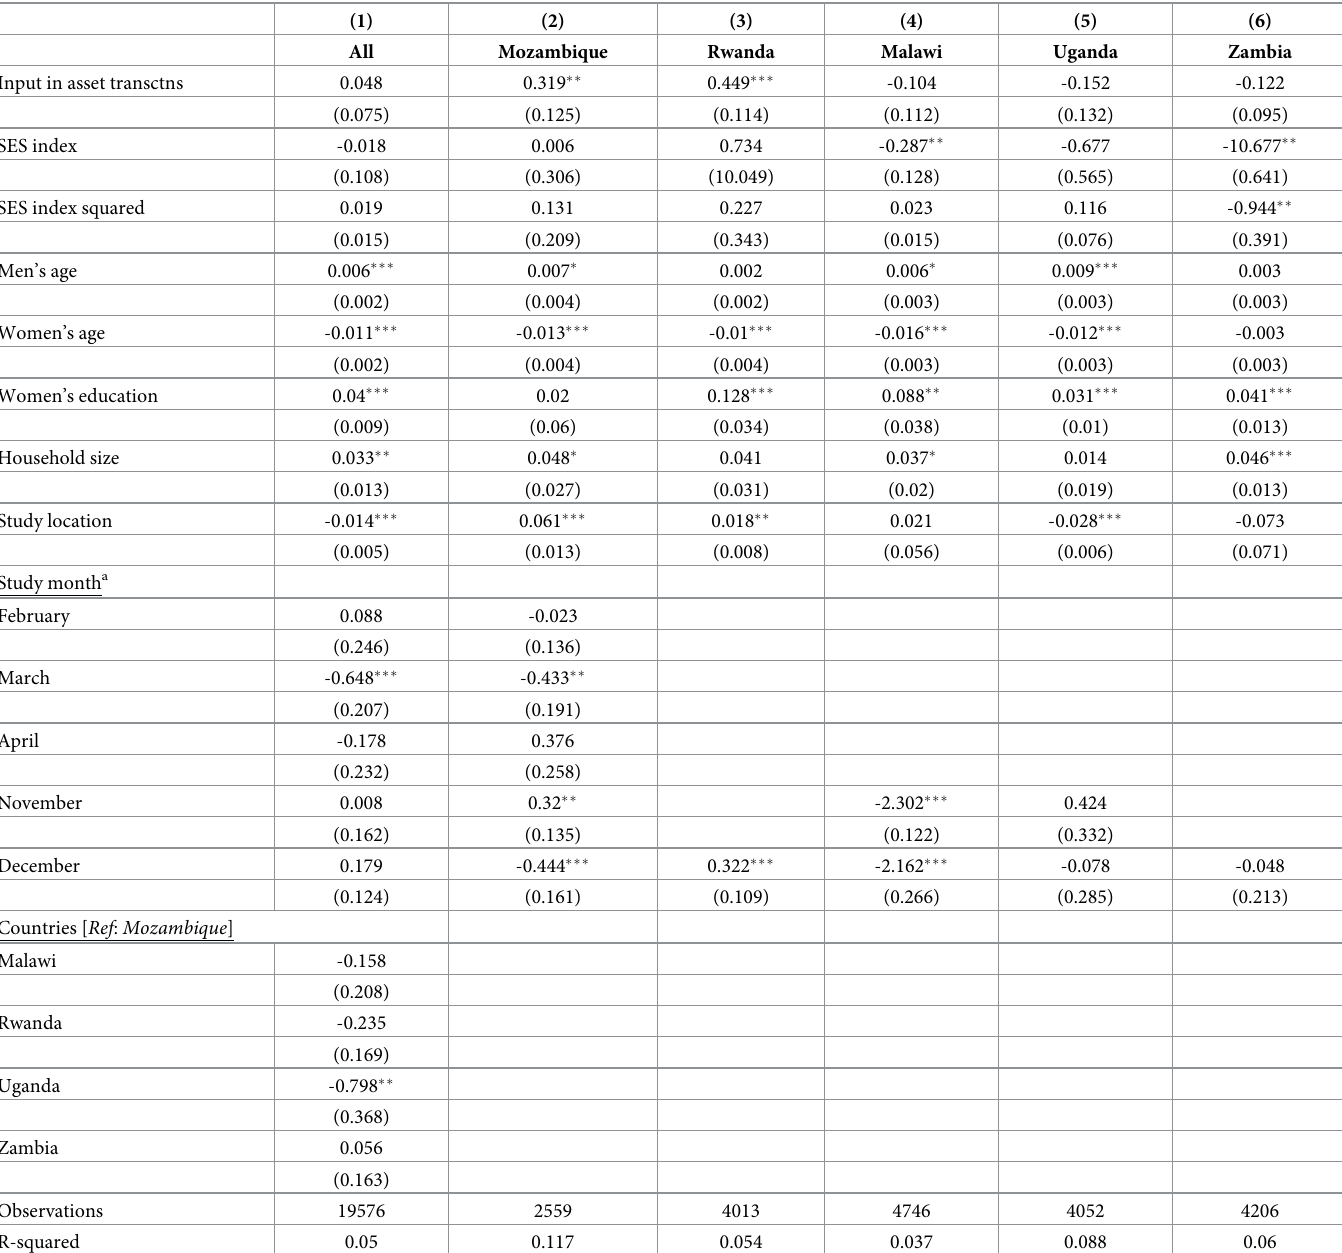
Table 8. OLS regression results for WDDS–resources domain (sole/joint decision in � 1 asset sale, purchase, and